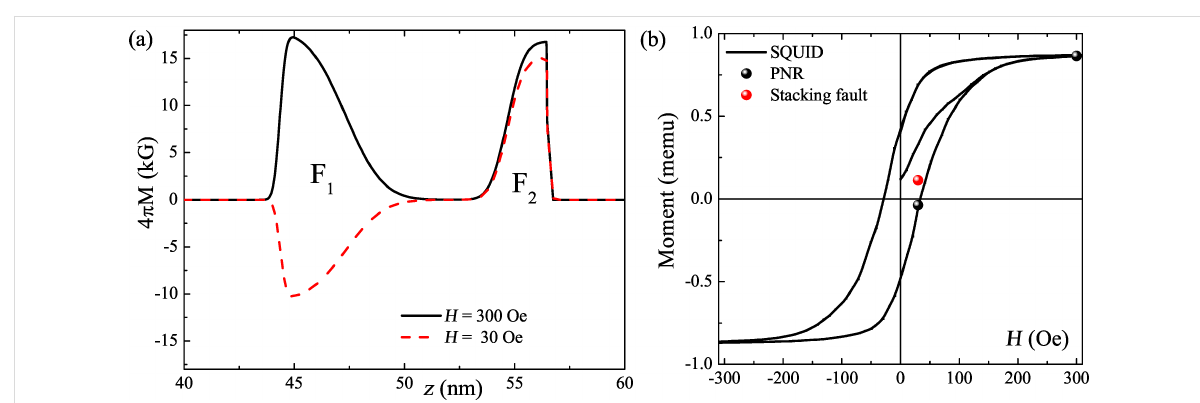
Figure 4: (a) Magnetic depth profiles of one unit cell for the P (black) and AP (red) alignment. Corresponding neutron curves are shown by solid lines in Figure 3a. (b) Hysteresis loop measured by SQUID magnetometry (solid line). The black dot indicates the magnetic moment of the sample which is obtained by the integration of the depth profiles depicted in (a). The red dot shows the magnetic moment at H = 30 Oe expected if one P segment were present in the AP aligned